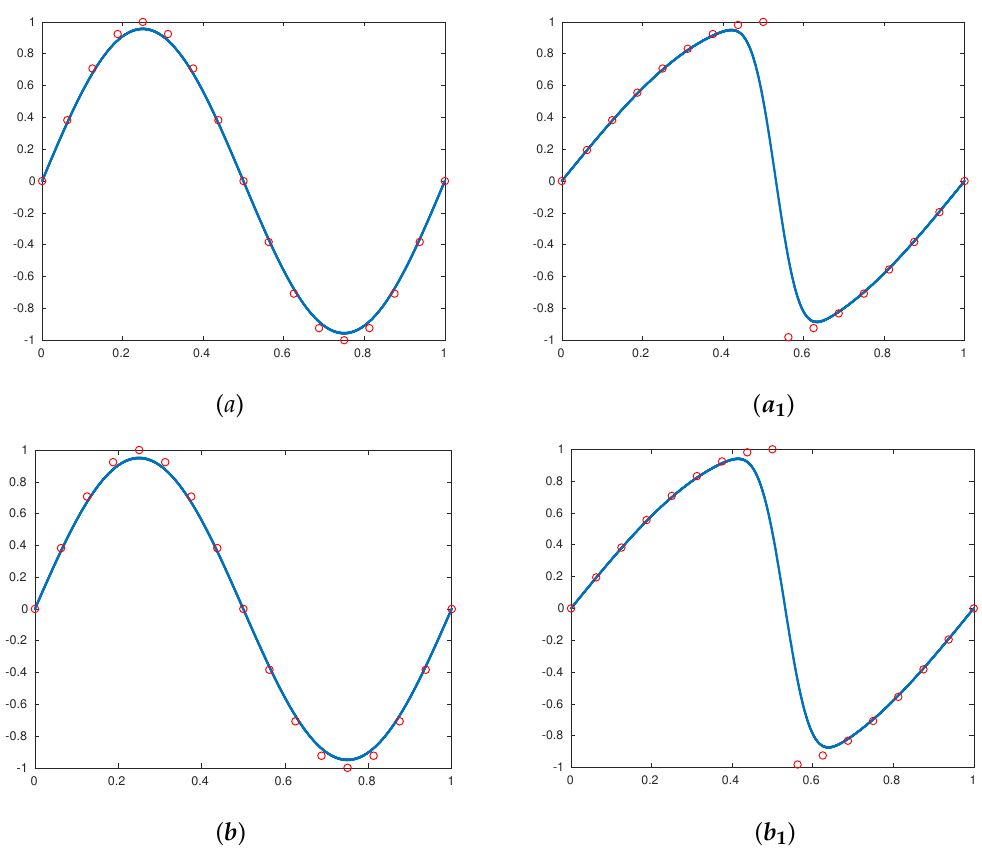
Figure 3. Images on the left were obtained using the continuous function defined in (33), images on the right were obtained using the discontinuous function (34), using five subdivision scales; the results shown in ( a ), (also a 1 ) and ( b ), (also b 1 ) were obtained by S 5 (17) and S 6 (19), respectively, . In this figure, the original sampling is represented in ◦ . where w = 1 3